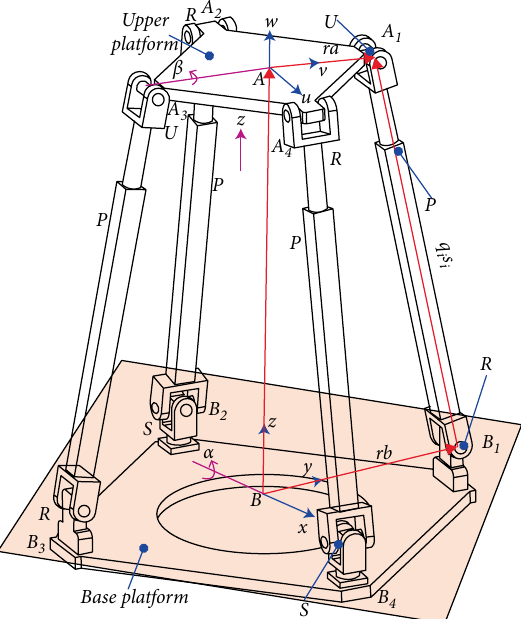
Figure 2: Schematic diagram of 3-DOF parallel